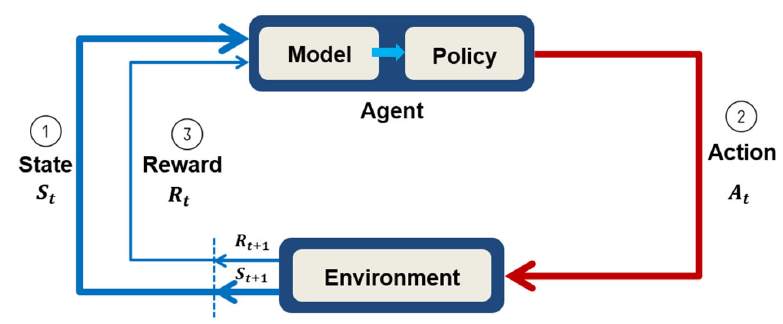
Figure 1. Markov decision process model [6]